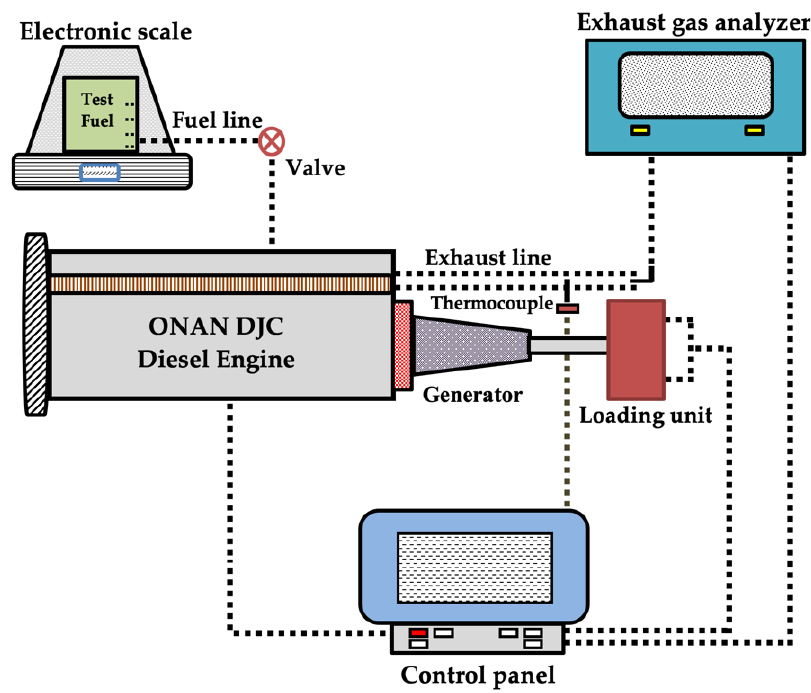
Figure 1. Schematic view of experimental facility. Table 4. Accuracies of the measurements and the uncertainties of the calculated quantities. Test